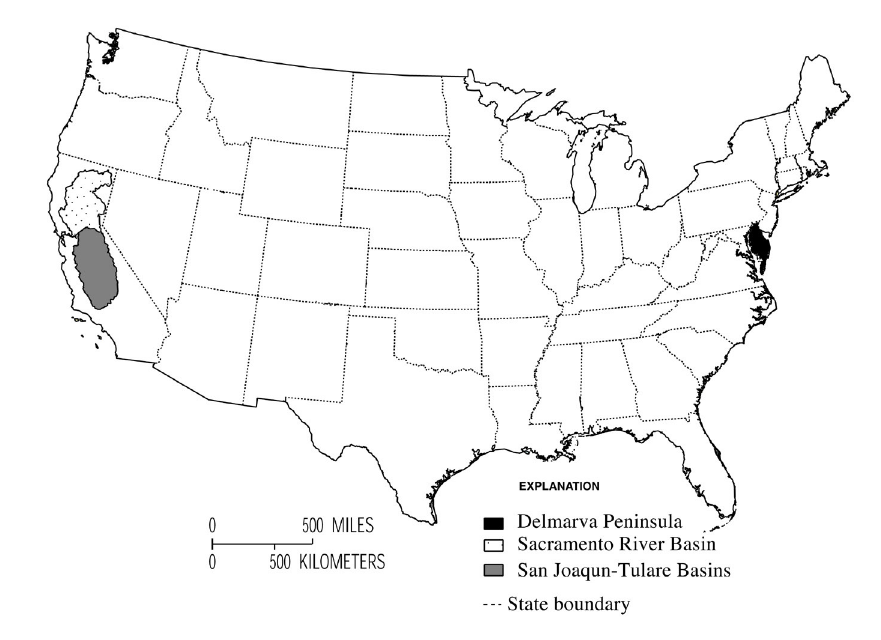
FIGURE 2. Map of U.S. showing the Delmarva Peninsula, the Sacramento River Basin, and the San Joaquin–Tulare